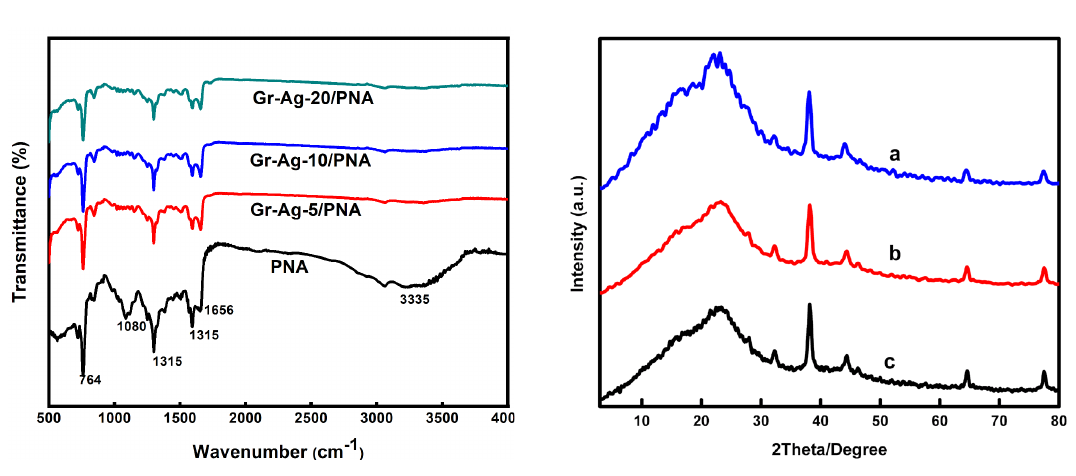
Fig. 1. FTIR spectra of PNA and Gr-Ag/PNA nanocomposites Fig. 2. XRD pattern of (a) Gr-Ag-5/PNA, (b) Gr-Ag-10/PNA and (c) Gr-Ag-20/PNA